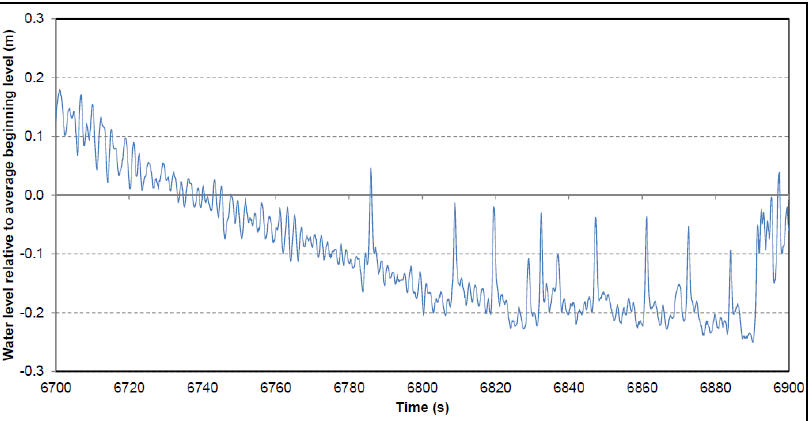
Figure 4. The measured water-level fluctuations associated with the arrival of the ship